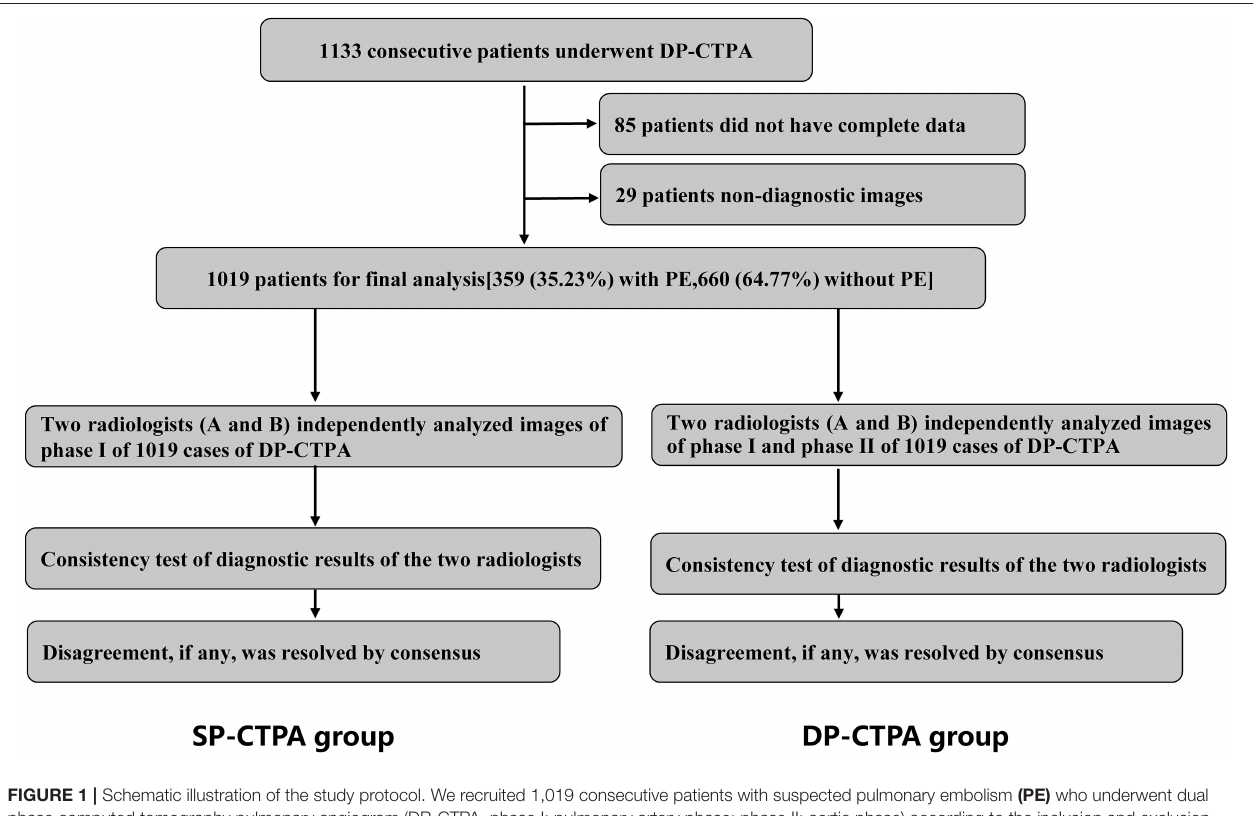
FIGURE 1 | Schematic illustration of the study protocol. We recruited 1,019 consecutive patients with suspected pulmonary embolism (PE) who underwent dual phase computed tomography pulmonary angiogram (DP-CTPA, phase I: pulmonary artery phase; phase II: aortic phase) according to the inclusion and exclusion criteria. Phase I DP-CTPA images of all patients were used as the single phase-computed tomography pulmonary angiography (SP-CTPA) group. Images of SP-CTPA group were independently analyzed and diagnosed by two experienced radiologists (A and B). Consistency test of diagnostic results of the two radiologists was performed. After an interval of 1 week, the two radiologists analyzed the DP-CTPA group following the same process. The diagnostic efficacy of SP-CTPA and DP-CTPA for the diagnosis of PE was compared using the final clinical diagnosis (FCD) as